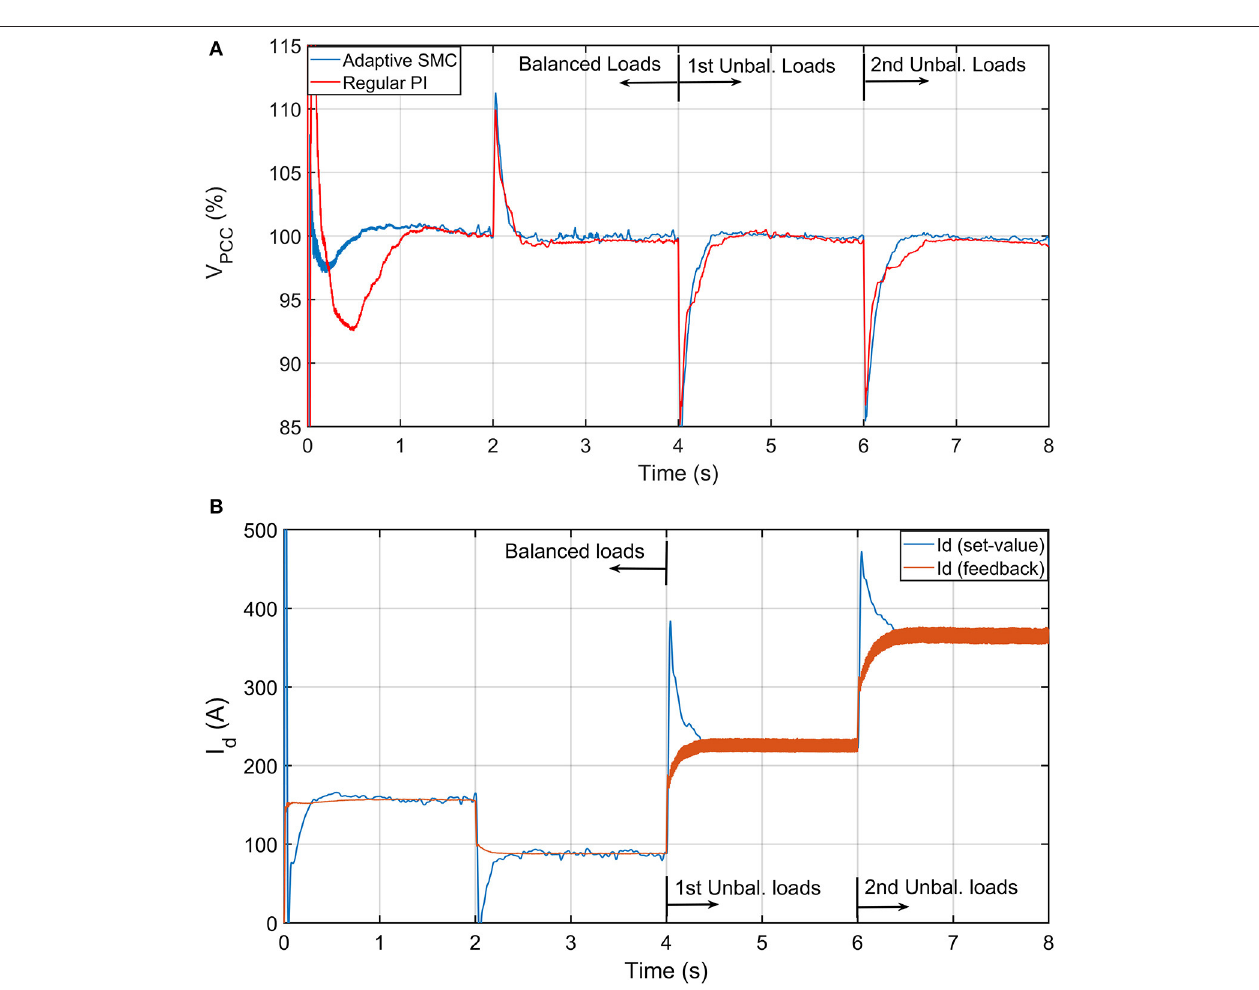
FIGURE 6 | Performance of proposed operational (control) scheme for voltage stability at PCC. (A) Performance of adaptive SMC vs. PI controllers for voltage stability. (B) Performance of currents in current control loop of d-axis.